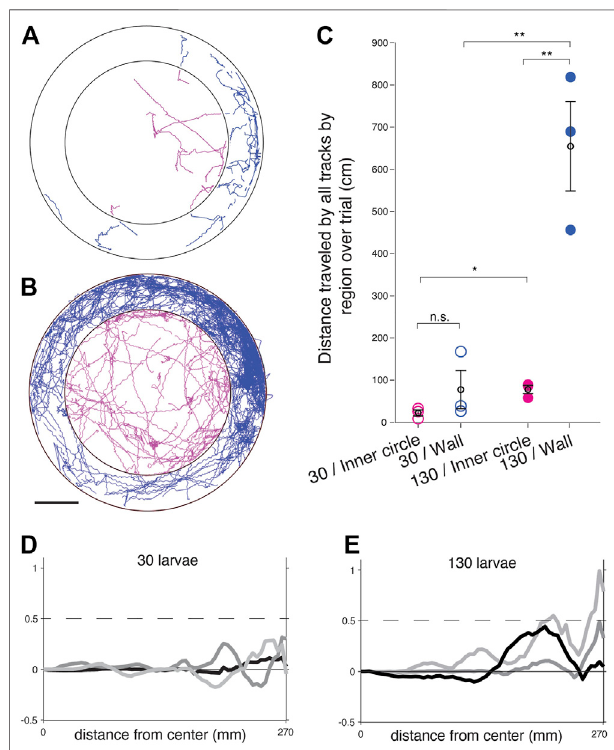
FIGURE3| Larvalzebra fi shtraversespacedifferentlyatdifferentdensities when bordering the arena wall in comparison to in the center of the arena. (A) Trajectoriesforatrialwith30larvaesegregatedintoanouterringadjacenttothe wall (blue) and the arena center (magenta). (B) Trajectories for a trial with 130larvaesegregatedintoanouterringadjacenttothewall(blue)andthearena center (magenta). Scale bar for A-B 1 cm. (C) Summed distance traveled in cm foralltracksinatrial.Trialswith30larvae(opencircles)werecomparedtotrialsof 130 larvae ( fi lled circles) and wall-adjacent regions (blue) were compared to the inner circle of the arena (magenta). Means per group are in black open circles and error bars are the SEM. n.s. (cid:2) not signi fi cant, * p < 0.05, ** p < 0.01. (D – E) . Meantangentialvelocity < v > versustheradialdistancefromthedishcenterfor3 trials each of n (cid:2) 30 (D) and n (cid:2) 130 (E) larvae.